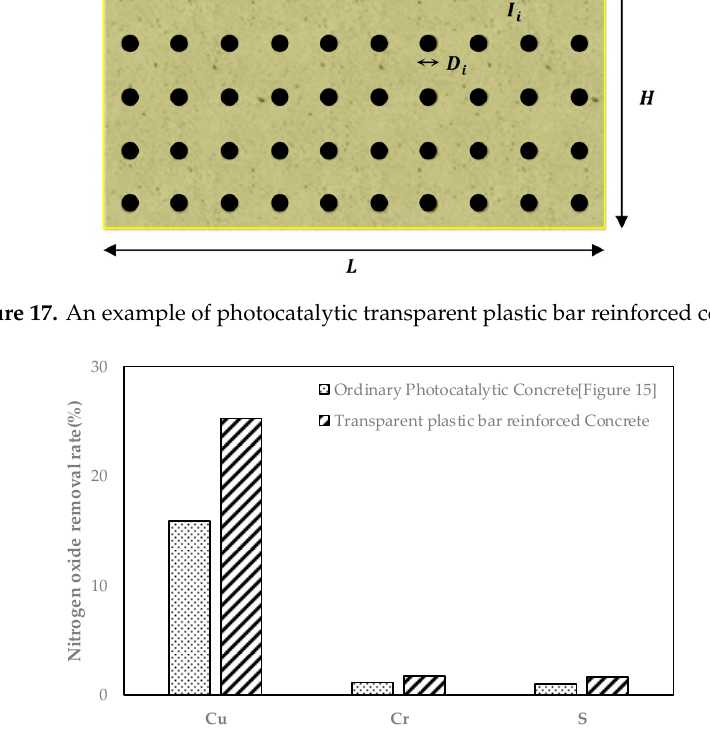
Figure 18. Estimation of nitrogen oxide removal rate of doped TiO 2 -incorporated transparent plastic bar reinforced concrete.